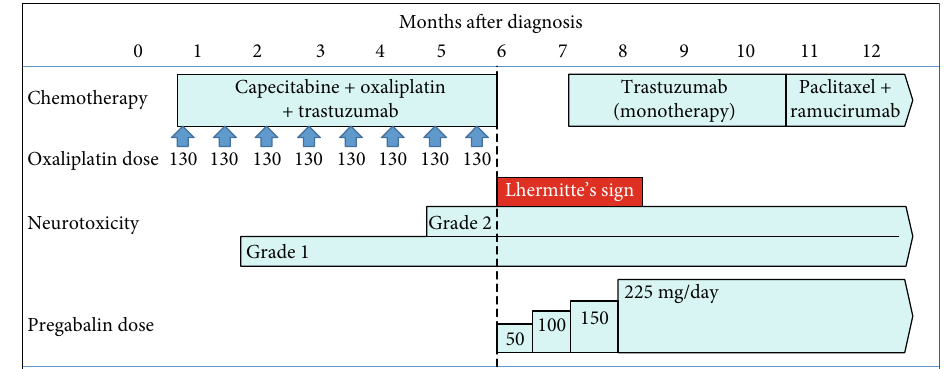
Figure 2: Course of treatment during the fi rst year after diagnosis of gastric cancer. Table 1: Comparison between our case and 13 colorectal cancer patients with OLS. Gastric